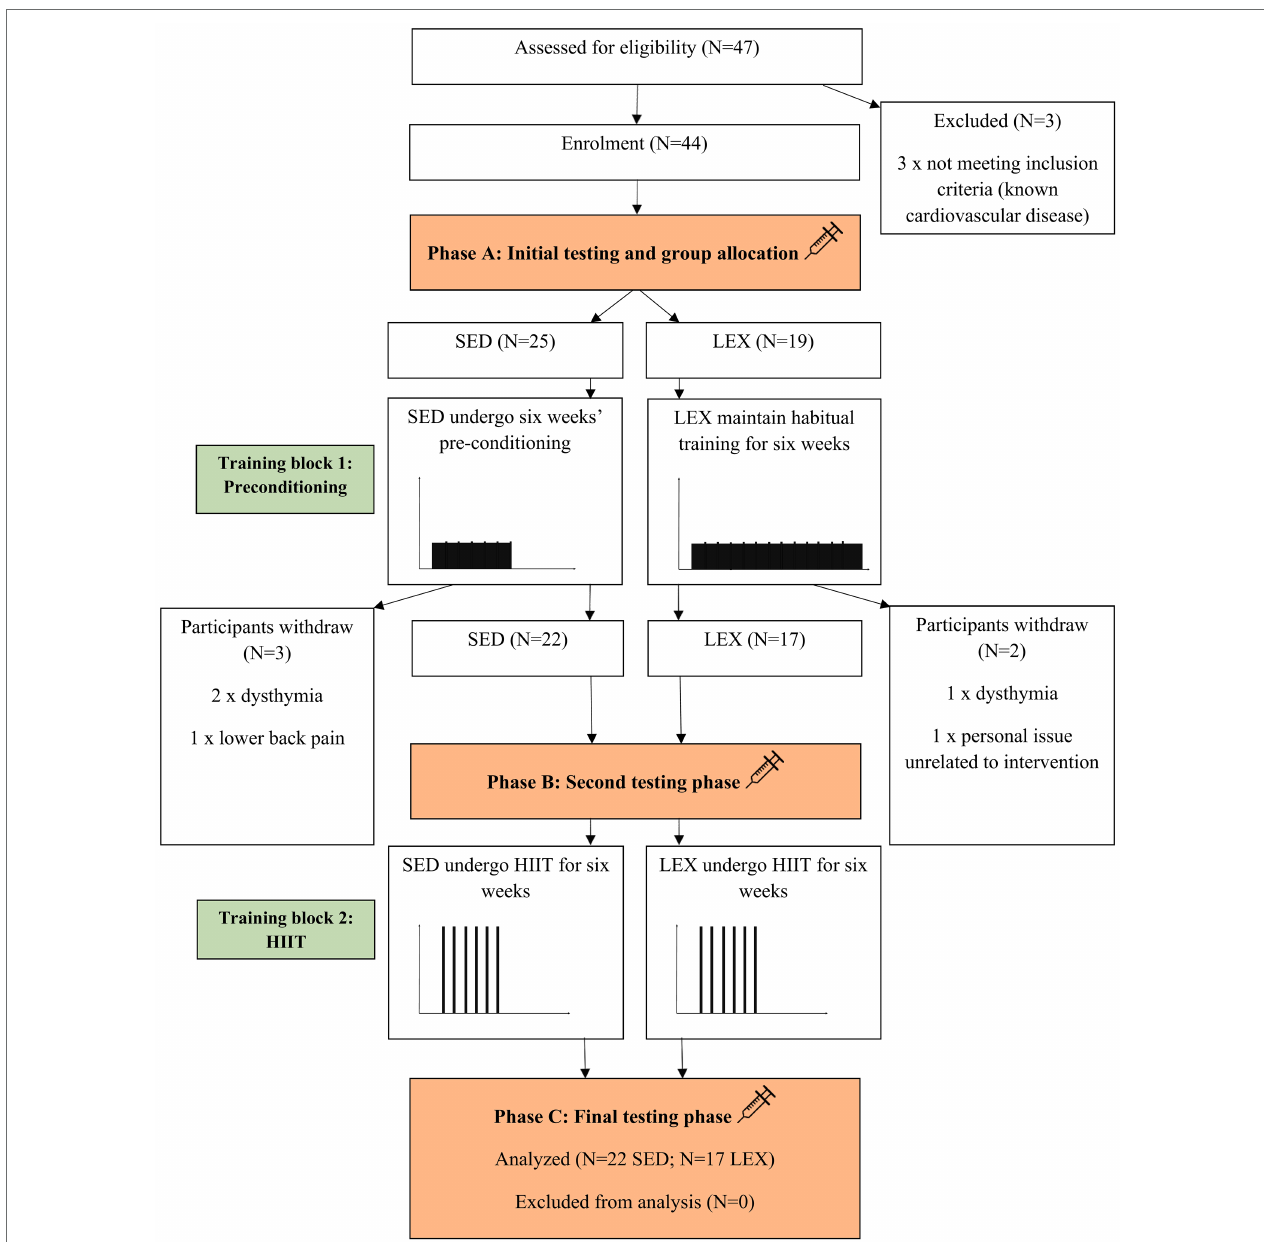
FIGURE 1 | The Consolidated Standards of Reporting Trials (CONSORT) flow diagram detailing the experimental process in which lifelong exercising (LEX) and lifelong sedentary (SED) men completed the intervention. HIIT = high-intensity interval